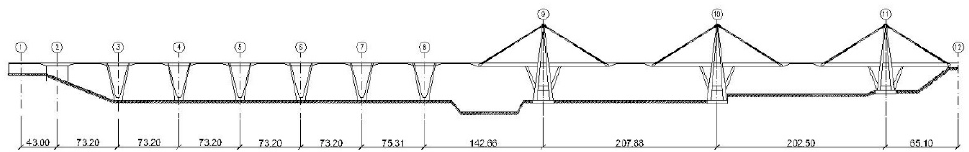
Figure 2. Structural scheme of the viaduct and the multi-span overpass (Morandi, 1968; dimensions in m).